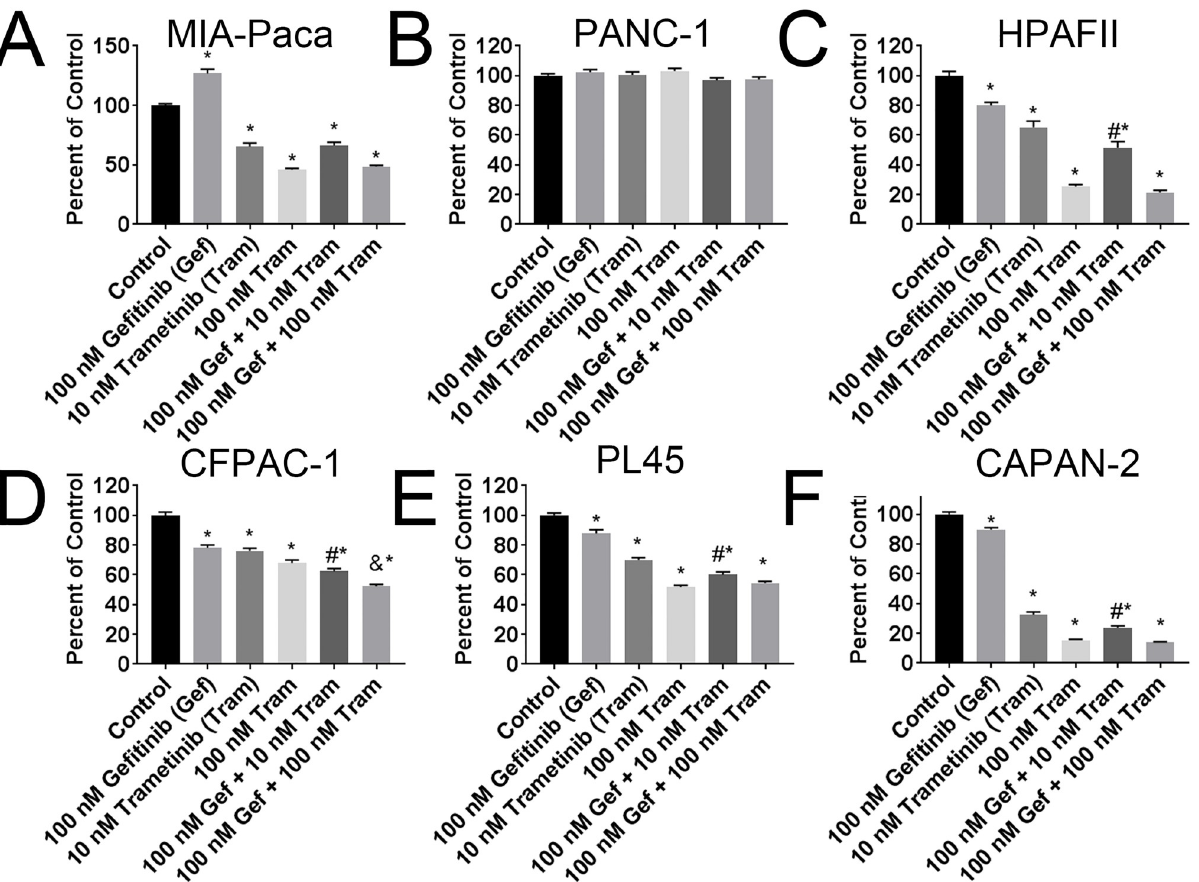
Fig 5. Combination treatment of gefitinib and trametinib in select cell lines. MTT of 3-day treatment of the 100 nM gefitinib alone or in combination with 10 nM or 100 nM trametinib in (A) MIA-PACA, (B) PANC-1, (C) CFPAC-1, and (D) HPAF-II. MTT of 6 day treatment of the 100 nM gefitinib alone or in combination with 10 nM or 100 nM trametinib (E) PL45, and (F) CAPAN-2 cells. � denotes p < 0.05 when compared to control by one-way ANOVA and Tukey post-test. # denotes p < 0.05 when compared to 100 nM gefitinib alone and 10 nM trametinib alone by one-way ANOVA, Tukey post-test, and Chou Talalay CI value equal to or less than 1. & denotes p < 0.05 when compared to 100 nM gefitinib alone and 100 nM trametinib alone by one-way ANOVA, Tukey post-test, and Chou Talalay CI value equal to or less than 1. Assays were completed in triplicate.